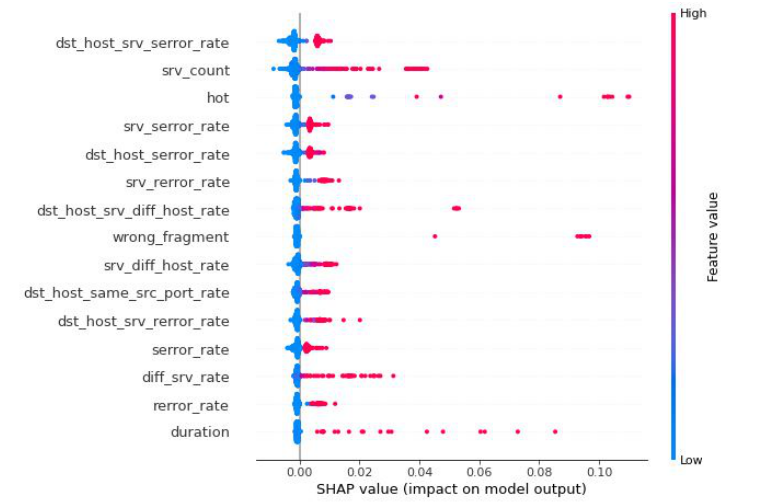
Figure 4. Summary plot of SHAP values calculated for the NSL-KDD dataset using the EIF model of the MemAE-EIF